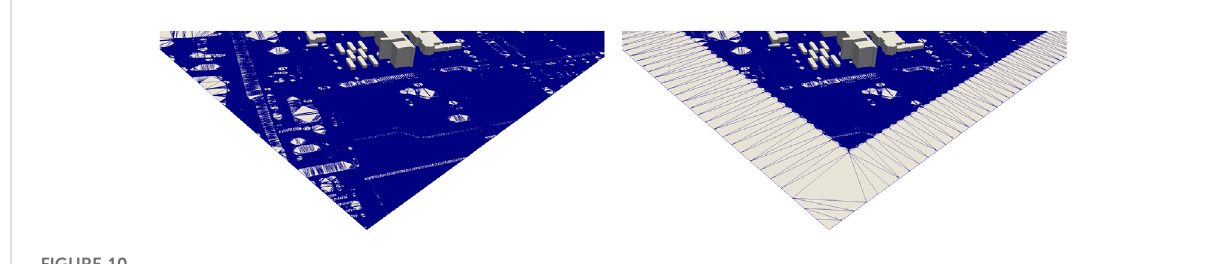
FIGURE 10 Adding a buffer zone to the edge of